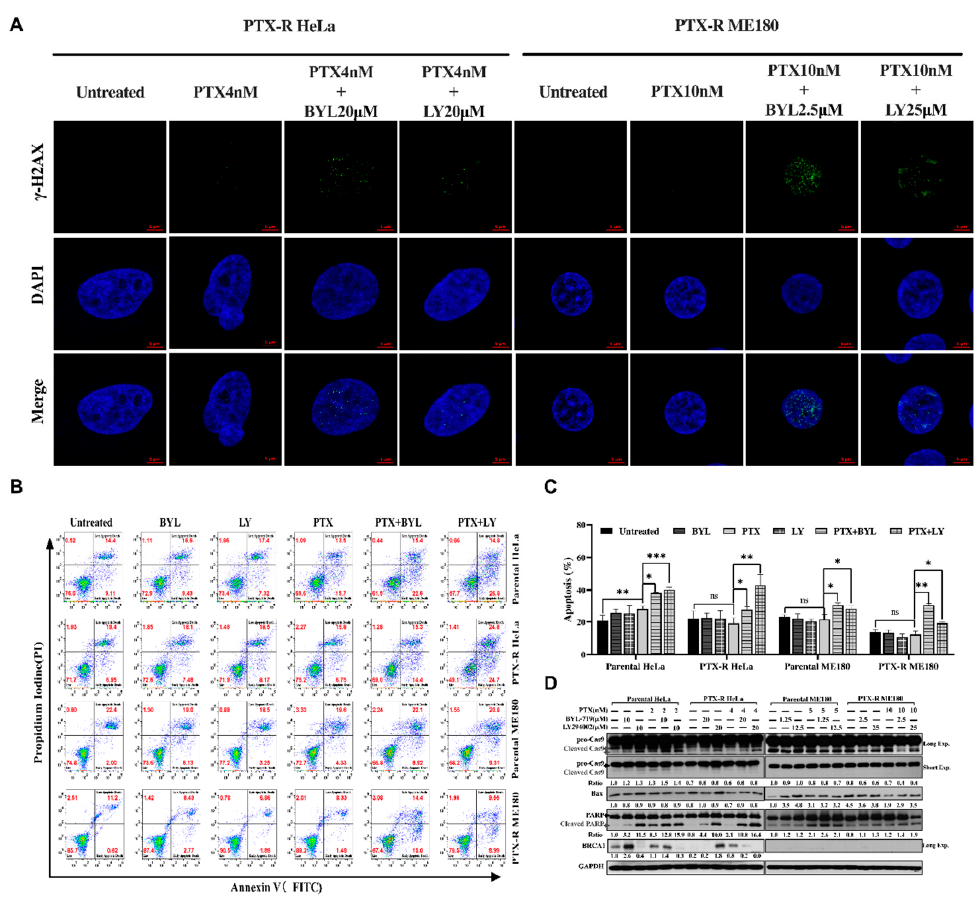
Figure 5. The e ff ect of a combination BYL-719 or LY294002 with a low dose of paclitaxel on DNA damage and cell apoptotic e ff ects on parental and paclitaxel-resistant HeLa and ME180 cells following 48 h treatment. ( A ) The representative images formation of γ -H2AX foci (green) counterstained with DAPI (blue) to distinguish nuclear morphology after paclitaxel treatment alone or in combination with BYL-719 or LY294002 in both PTX-R HeLa and ME180 cell lines at 48h. The scale bar = 10 µ m. At least 100 cells were counted in each experiment. The cells with ≥ 5 γ -H2AX discrete foci / nucleus were scored as positive. ( B ) The representative flow cytometry profiles of a comparison of combined BYL-719 (or LY294002) and paclitaxel treatment of parental and paclitaxel-resistant HeLa and ME180 cells as well as column graphs ( C ) showed that BYL-719 or LY294002 significantly potentiated the pro-apoptotic e ff ects of paclitaxel in both parental and paclitaxel-resistant HeLa and ME180 cells compared to each drug alone. The data are presented as the mean ± standard deviation (SD) of three experiments; * p < 0.05; ** p < 0.01; *** p < 0.001. ( D ) The representative bands (the mean value from three